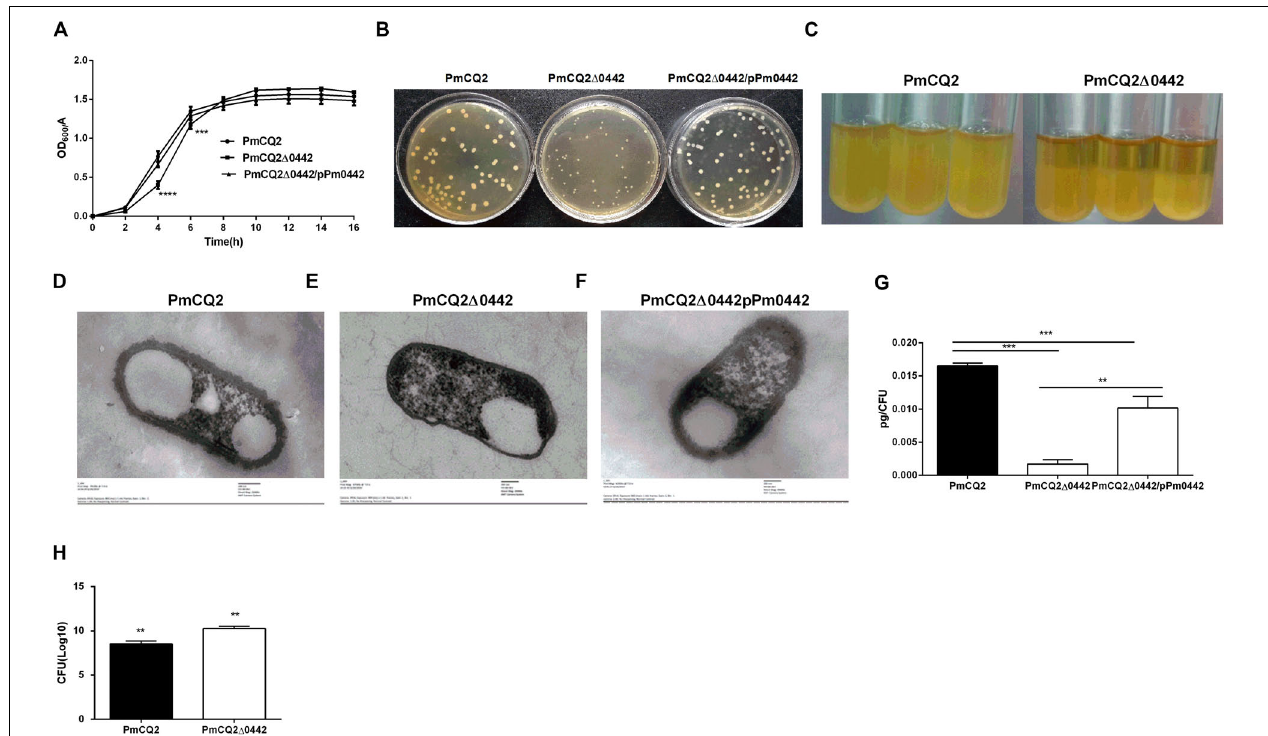
FIGURE 2 | PmCQ2 (cid:49) 0442 characteristics. (A) Bacterial growth curves based on OD 600 nm reading. (B) Colony morphology. (C) PmCQ2 (cid:49) 0442 and PmCQ2 strains after standing for the same time. (D–F) Capsule thickness of fresh cultured PmCQ2 (D) , PmCQ2 (cid:49) 0442 (E) and PmCQ2 (cid:49) 0442/pPm0442 (F) by TEM. (G) The content of capsule polysaccharide in PmCQ2, PmCQ2 (cid:49) 0442, and PmCQ2 (cid:49) 0442/pPm0442. (H) The number of PmCQ2 (cid:49) 0442 associated with macrophages. (A,B) were pooled from three independent experiments with three replicates per group. Panels (G,H) were pooled from two independent experiments with eight replicates per group. And (H) were determined by multiple comparative analysis, (G) was analyzed by unpaired t -test. All data were expressed as means ± SD. (** P < 0.01, *** P < 0.001, **** p < 0.0001). TABLE 3 | Determination of the LD50 in PmCQ2 and PmCQ2 (cid:49) 0442.